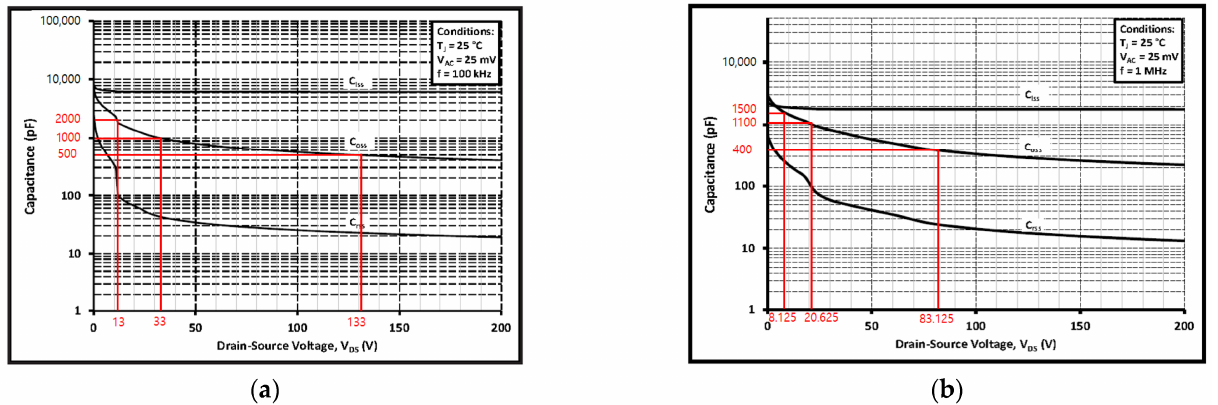
Figure 6. Parasitic capacitance by drain–source voltage of MOSFET: ( a ) C3M0016120K; ( b ) C3M0030090K.